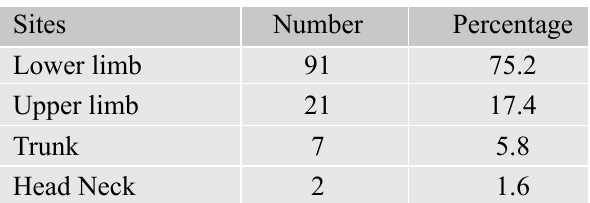
Table II: Sites of snake